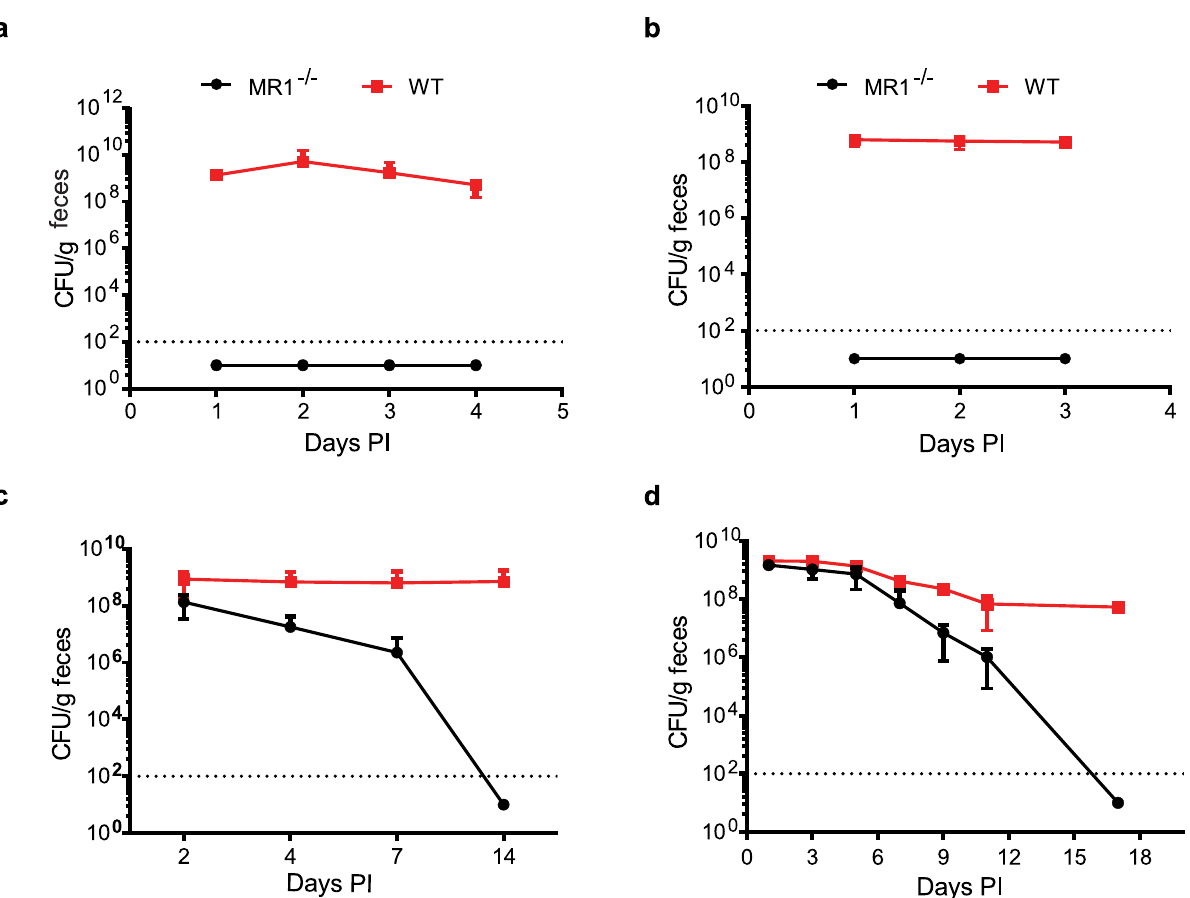
Fig 2. MR1 -/- mice exhibit resistance to Cd colonization in multiple infection models. (A) Cd colonization in WT and MR1 -/- mice in the standard cefoperazone model of CDI. WT n = 9, MR1 -/- n = 8. Data presented are mean ± SD. (B) Colonization levels were determined for WT and MR1 -/- mice pretreated with cefoperazone then inoculated with vegetative Cd cells and followed for three days PI. WT n = 5, MR1 -/- n = 6. Data presented are mean ± SD. (C) Colonization levels in WT and MR1 -/- mice for 14 days after streptomycin pretreatment and inoculation with Cd spores. n = 11 mice per group. Data presented are mean ± SD of colonization results from all mice across three independent experiments (n = 11 per group total). (D) Mice were pretreated with a cocktail of five antibiotics in the drinking water for five days followed by a switch to normal water and a single IP injection of clindamycin one day prior to inoculation with Cd spores. Cd colonization was followed for 17 days PI. n = 11 mice per group. Data presented are mean ±